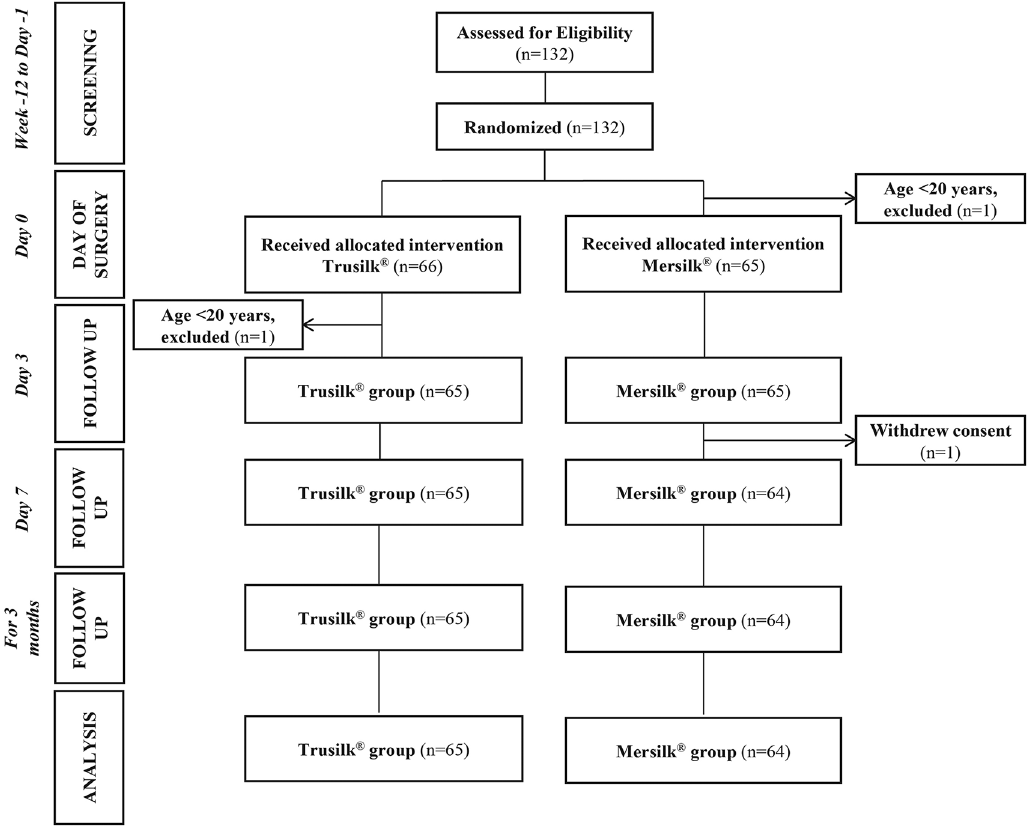
Figure 1. CONSORT flow